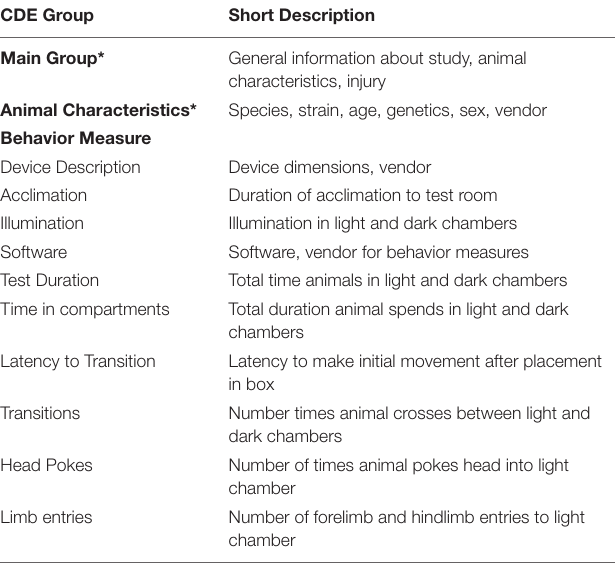
TABLE 3 | Common data elements for light-dark box (LDB)